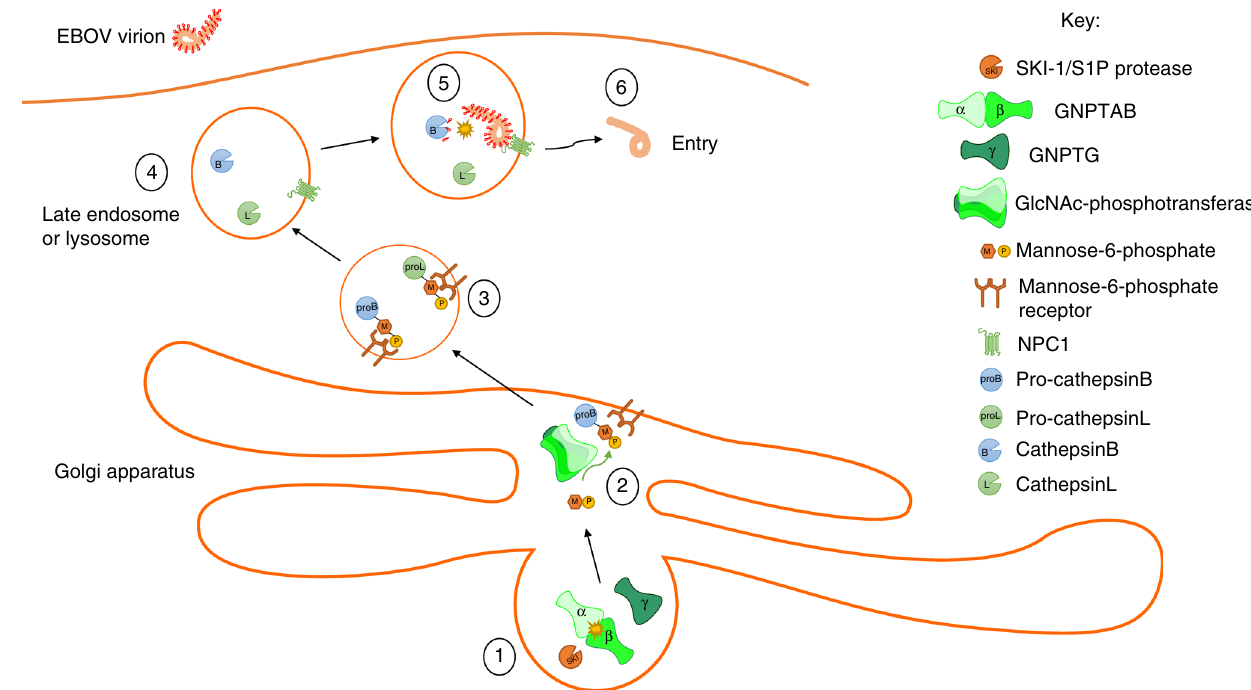
Fig. 7 Schematic of a model for the role of GNPTAB in EBOV entry. (1) The SKI-1/S1P protease cleaves the GNPTAB precursor to yield the individual α and β subunits, which then assemble with the γ subunit to form the GlcNAc-phosphotransferase enzyme. (2) GlcNAc-phosphotransferase catalyzes the transfer of mannose-6-phosphate onto the glycans of proteins destined to be transported to the lysosome, such as pro-cathepsin B and pro-cathepsin L. (3) The mannose-6-phosphate receptor recognizes its substrates and mediates their transport to the lysosome. (4) Once in the lysosome, pro-cathepsins cleave to yield the mature cathepsins. (5) The activated cathepsins cleave the EBOV GP, removing the glycan-cap and mucin-like domains, and allowing the receptor-binding site to interact with NPC1, priming the GP for fusion. (6) Following fusion, the viral nucleocapsid enters into the cell cytoplasm where replication can be initiated. Blocking GlcNAc-phosphotransferase activity, either by inhibition of the SKI-1/S1P protease at (1), or by the absence of functional enzyme in (2), has the effect of preventing EBOV